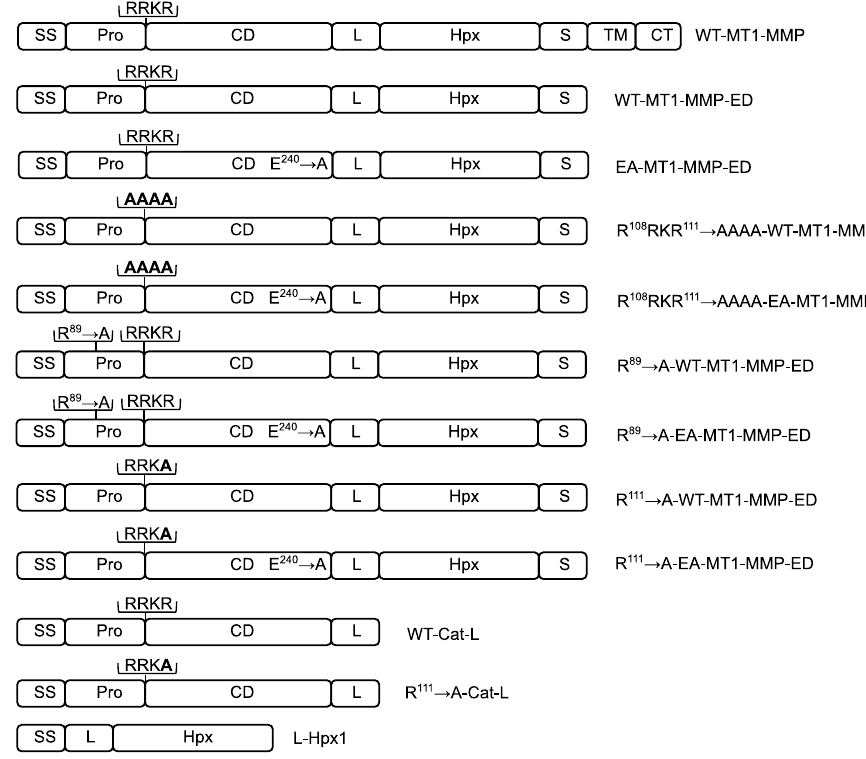
Figure 1. Schematic diagram of the WT-MT1-MMP domain structure and the truncated constructs used in the present study. The MT1-MMP domain configuration includes a signal sequence (SS), prodomain (Pro), catalytic domain (CD), linker (L), hemopexin-like domain (Hpx), stalk (S), trans- membrane domain (TM), and the cytoplasmic tail (CT). RRKR represents the furin cleavage site. RRKA and AAAA are the mutated versions that block the removal of the prodomain. Position 89 is the second cleavage site in the mammalian cells and the R 89 → A is the mutant used in this study.